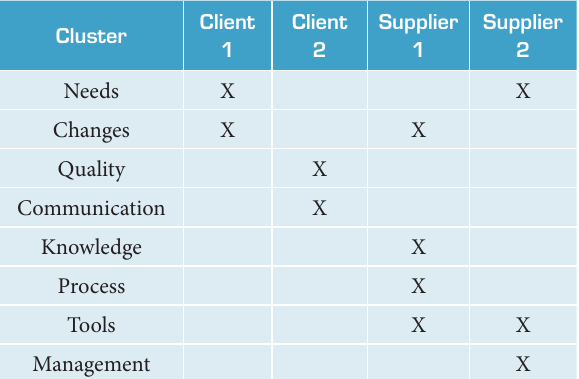
table 3. Common clusters on